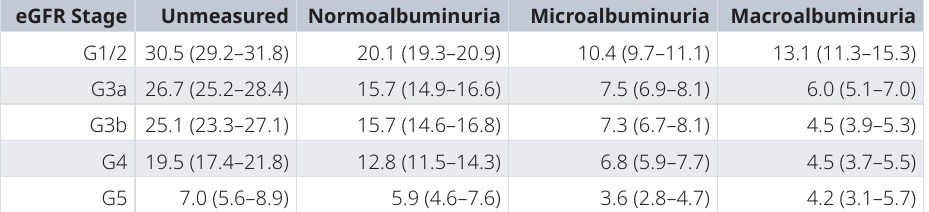
Table 3. Mean sojourn times, by albuminuria and eGFR stage. 95% confidence intervals shown in